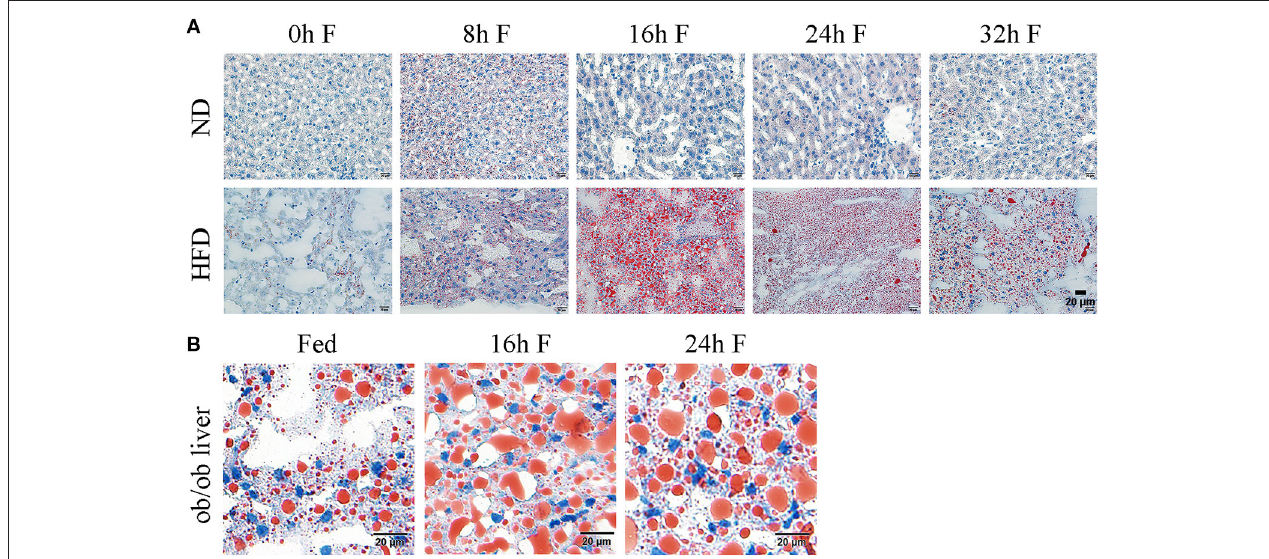
FIGURE 1 | Effects of fasting on the lipid droplet dynamics in the liver of obese mice. (A) Representative images of hepatic lipid droplet in HFD mice. ND, normal diet; HFD, high fat diet. Liver sections were stained with oil red O to display the lipid droplets (red) and counterstained with hematoxylin to display the nuclei (blue). Scale